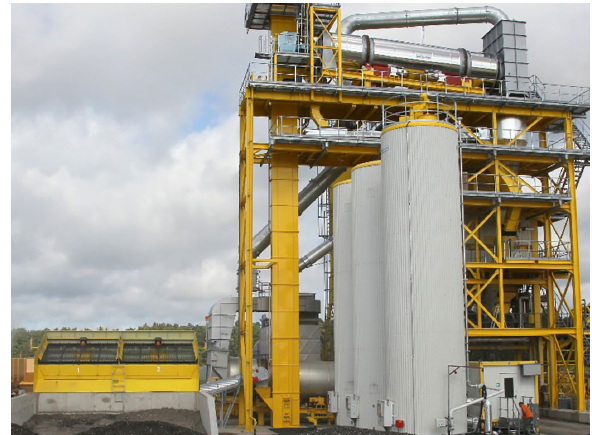
Figure 1. AMP with heating drum (bottom center) and parallel drum on top